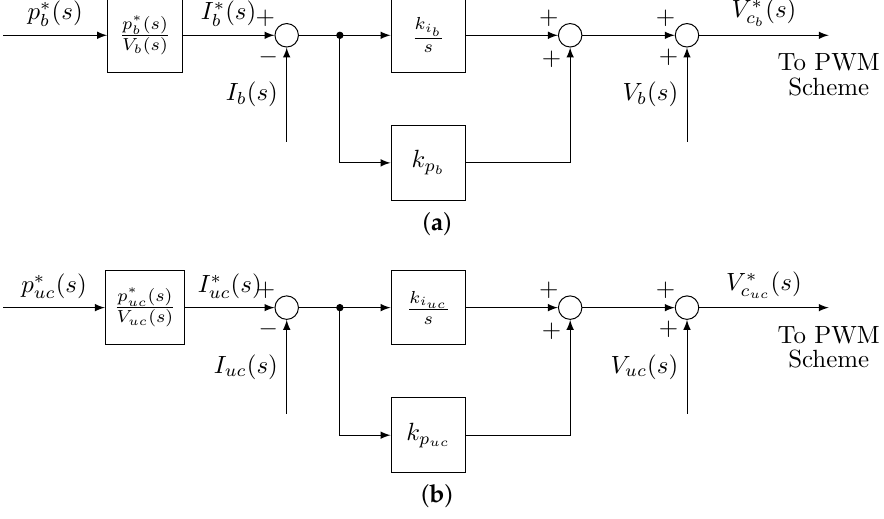
Figure 10. Control scheme of the DC–DC converters associated with ( a ) the batteries, and ( b ) the